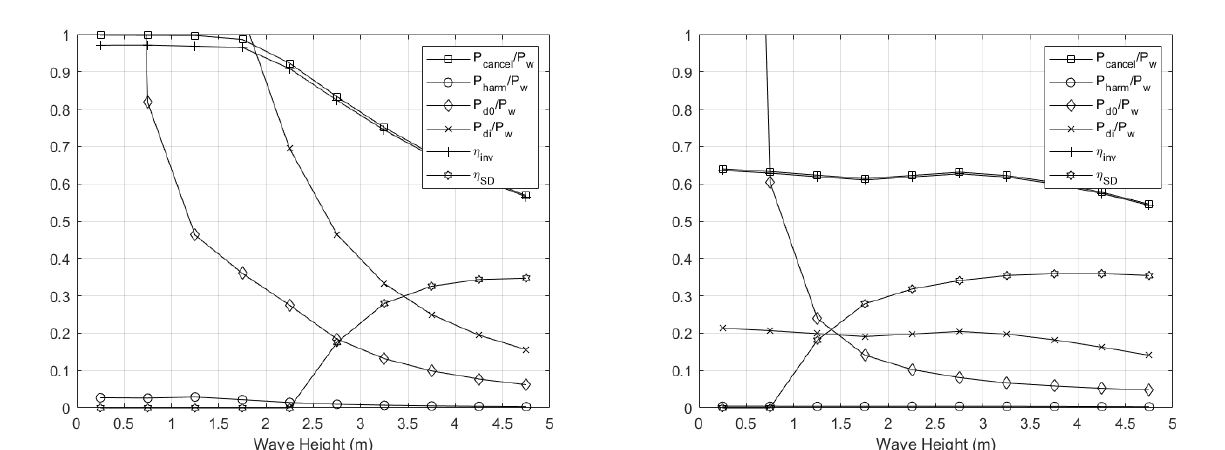
Fig. 7: Cancelled wave power, harmonic and drag power losses normalized with incoming wave power and inviscid and total efficiency of power conversion for the CycWEC at a wave period of 9s. Left, controller 1, Right, controller 2.